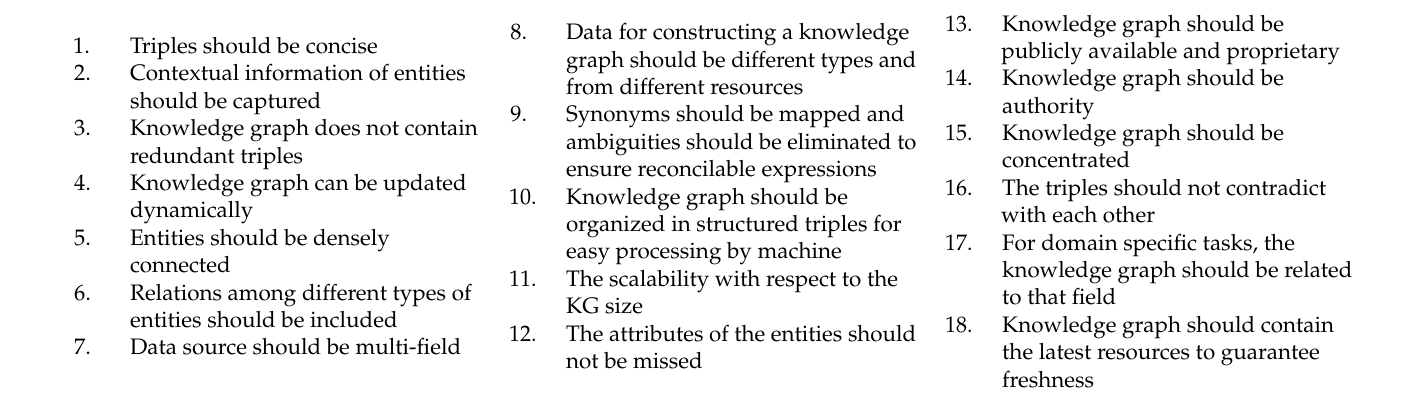
Table 2. Requirements of KG